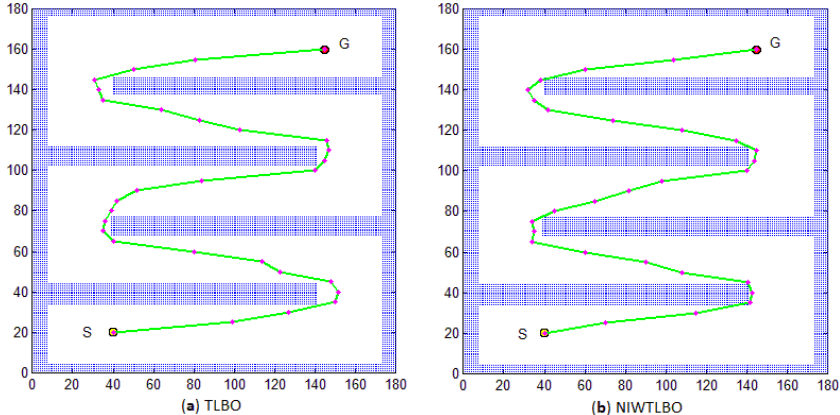
Figure 7. Path planning in the scenario of back_and_forth. D = 27. ( a ) The result of the TLBO; ( b ) The result of the NIWTLBO.